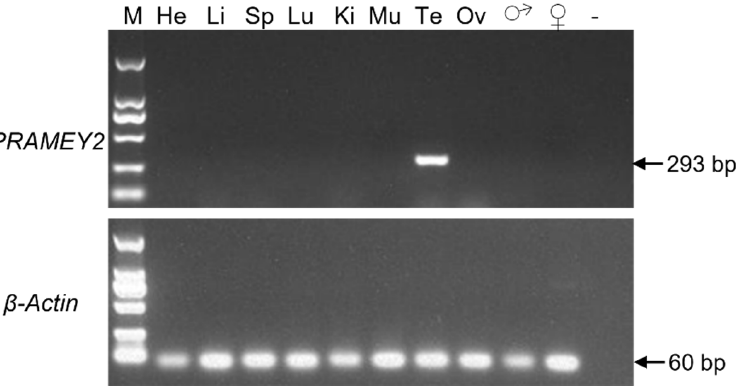
Figure 4. Tissue expression pattern of ovine PRAMEY . The PRAMEY was expressed specifically in testis. The β -Actin was used as an internal control for semi-quantitative RT-PCR. M: 2 kb DNA ladder; He: heart; Li: liver; Sp: spleen; Lu: lung; Ki: kidney; Mu: muscle; Te: testis; Ov: ovary; ♂ : male sheep genomic DNA; ♀ : female sheep genomic DNA; − : negative control (distilled water). The expression patterns of ovine PRAMEY were investigated by sqRT-PCR and qPCR.